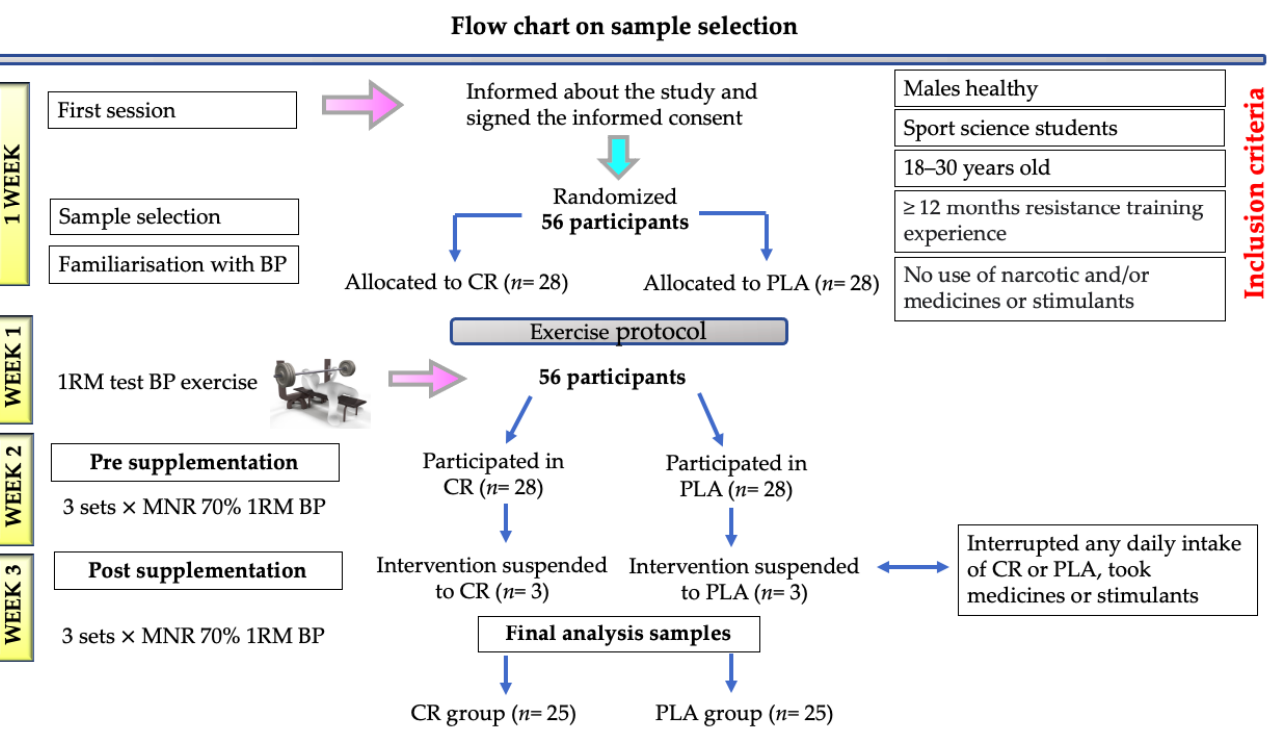
Figure 2. Summary of recruitment, allocation and final analysis samples. CR = creatine. PLA = placebo. BP = bench press. 1RM = one repetition maximum. MNR = maximum number of repetitions.